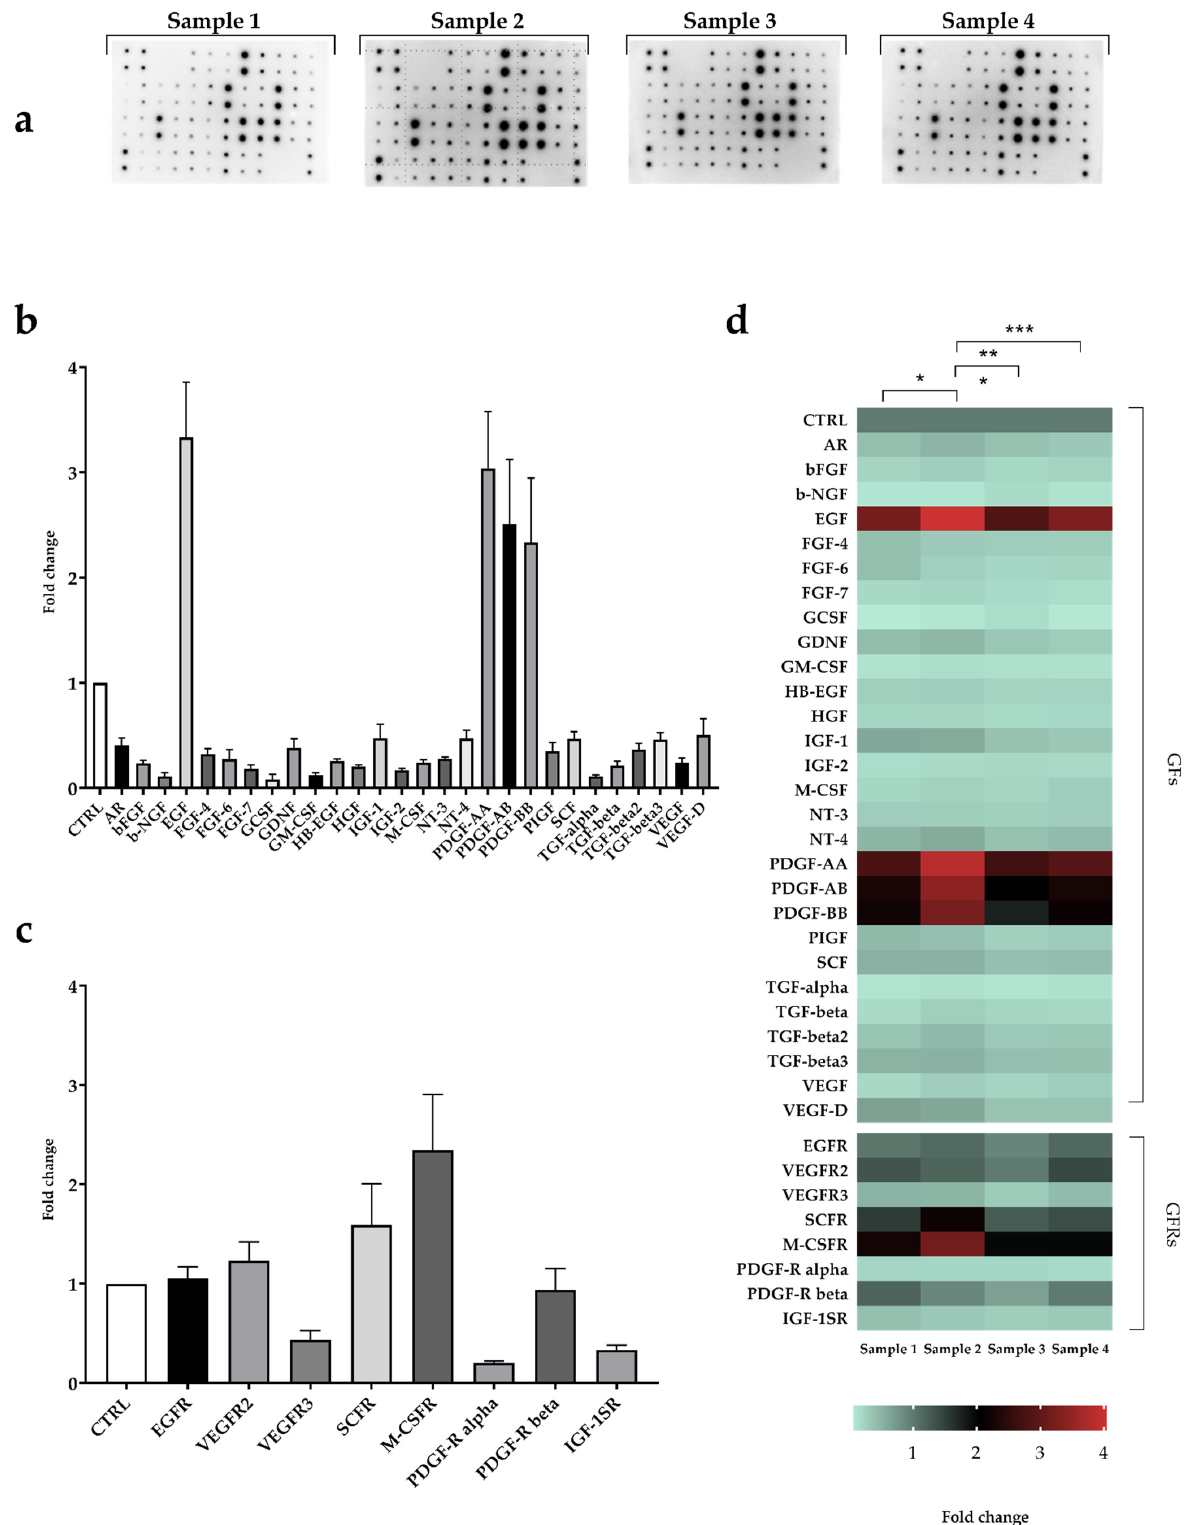
Figure 2. GFs and GFRs protein array. ( a ) chemiluminescence detection images of the Human Growth Factors Antibody Array membranes. Reference control (CTRL) was preloaded on the membrane by Manufacturer; ( b ) GFs and ( c ) GFRs densitometric data, expressed as mean fold change vs. control ± SD; ( d ) heatmap of the GFs and GFRs content of each PRP sample (analysis was performed in triplicate, * p < 0.05, ** p < 0.01, *** p <